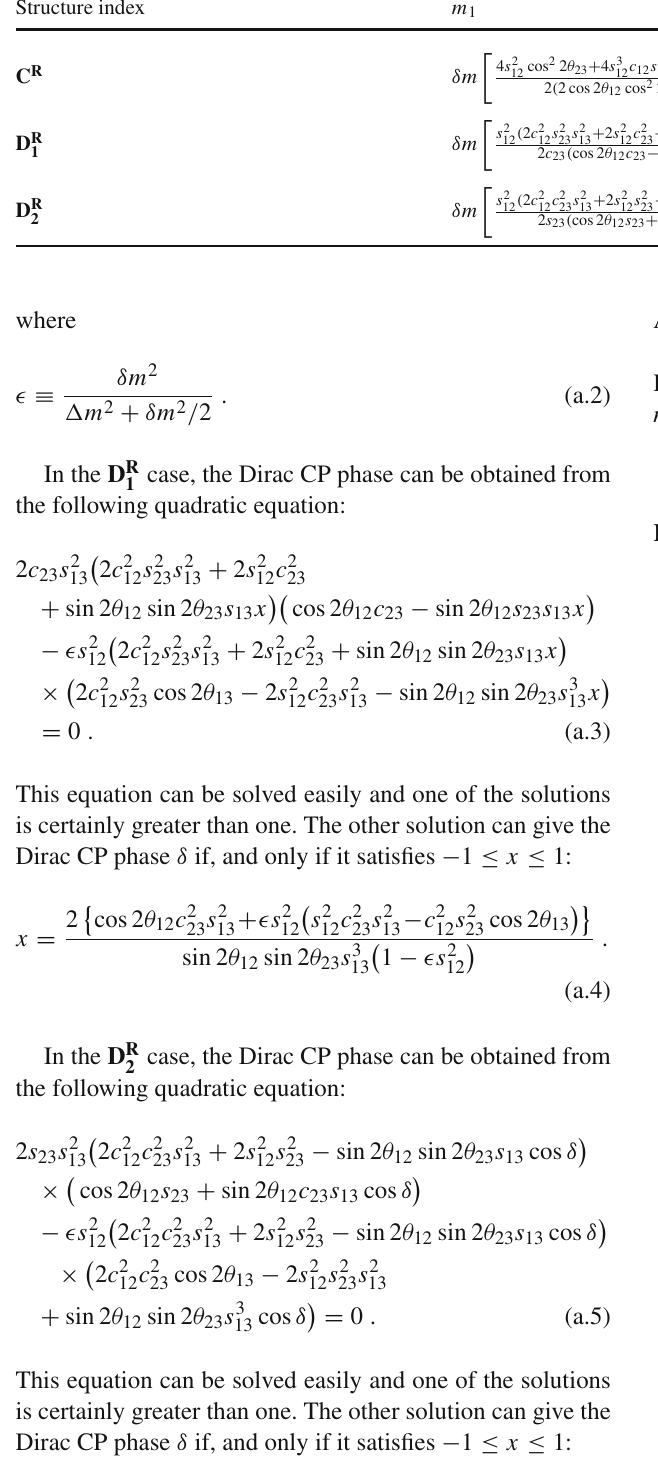
Table 8 The list of the formulae of the neutrino mass m 1 Structure